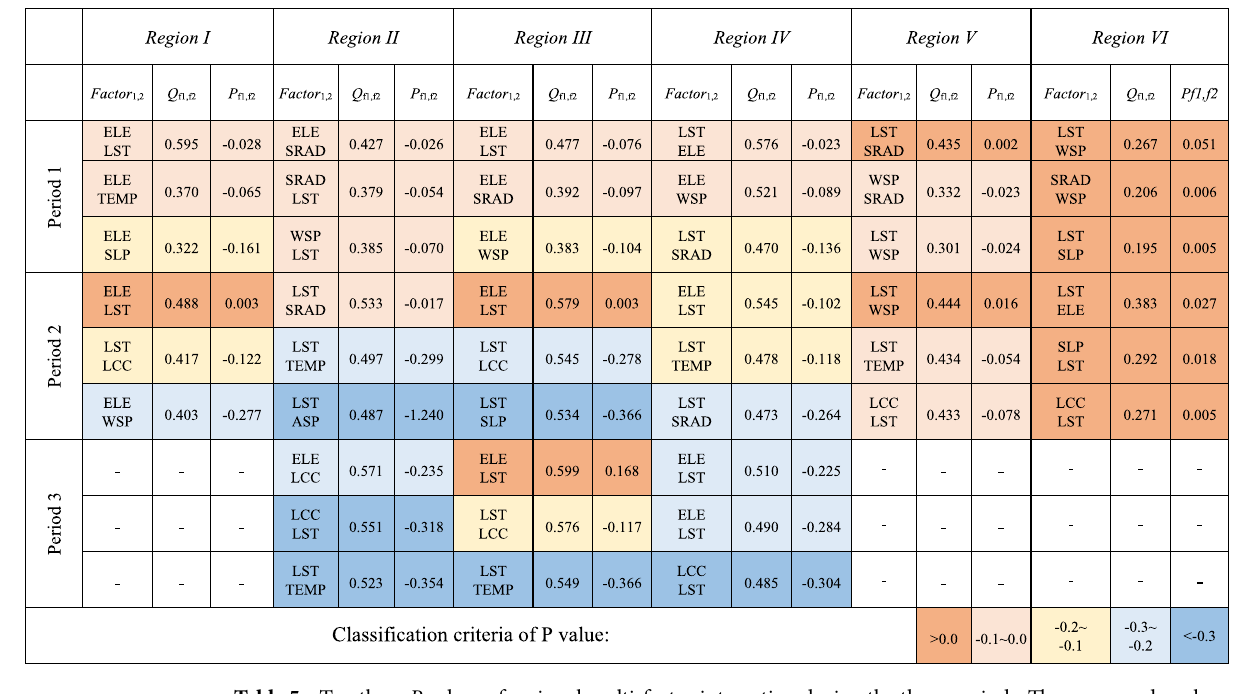
Table 5. Top three P values of regional multi-factor interaction during the three periods. The warm and cool colors are used to distinguish the Q and P values. The warmer the color is, the more important it is, and vice versa.